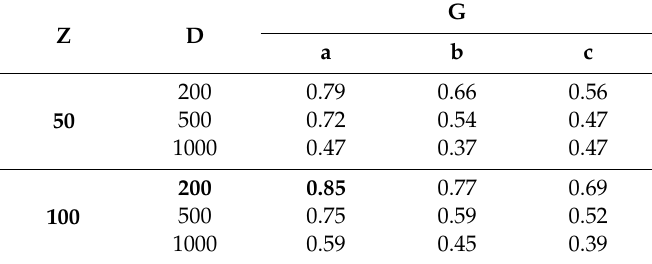
Table 1. DRUDIT parameter tuning. The selected values are indicated in bold.